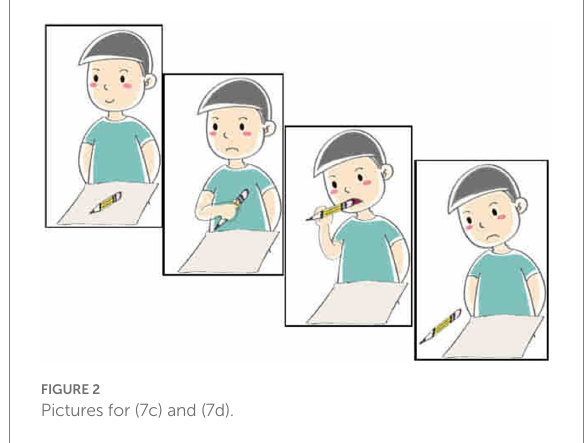
FIGURE 2 Pictures for (7c) and (7d).